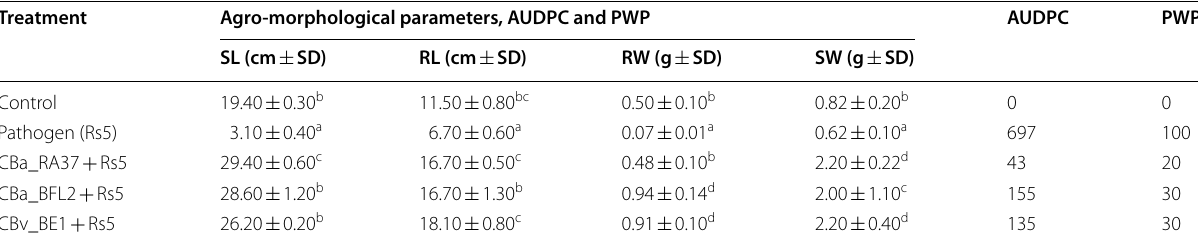
SL, shoot length; RL, root length; RW, root weight; SW, shoot weight; AUDP, area under the disease progress curve; PWP, percentage of wilt plant; control, Uninoculated seedlings; Rs5, R. solanacearum Rs5 infected plants without antagonist; CBa_RA37 Rs5, plantlets primed with Bacillus amyloliquefaciens CBa_RA37 alone and + grown on R. solanacearum Rs5 infected soil; CBa_BFL2 Rs5, plantlets primed with B. velezensis CBv_BE1 alone and grown on R solanacearum Rs5 infected soil; CBv_ + BE1 Rs5, plantlets primed with Bacillus velezensis CBv_BE1 alone and grown on R. solanacearum Rs5 infected soil; SD, standard deviation + Mean values within each column superscripted by the same letter (a, b, c, d, or e) are not significantly different ( P < 0.01) as given by the Turkey’s HSD post hoc test